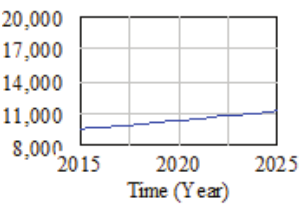
Fig. 9. CHP electricity demand.